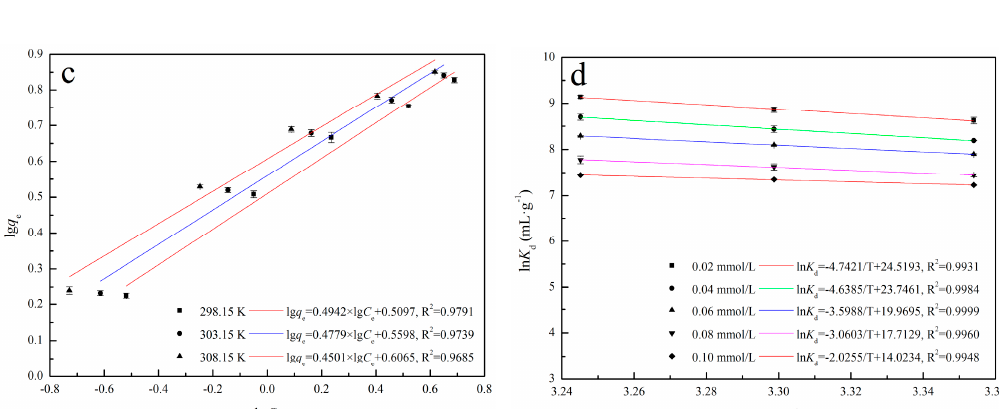
Table 2. Thermodynamic parameters for adsorption of Cd(II) on the imprinted biochar.